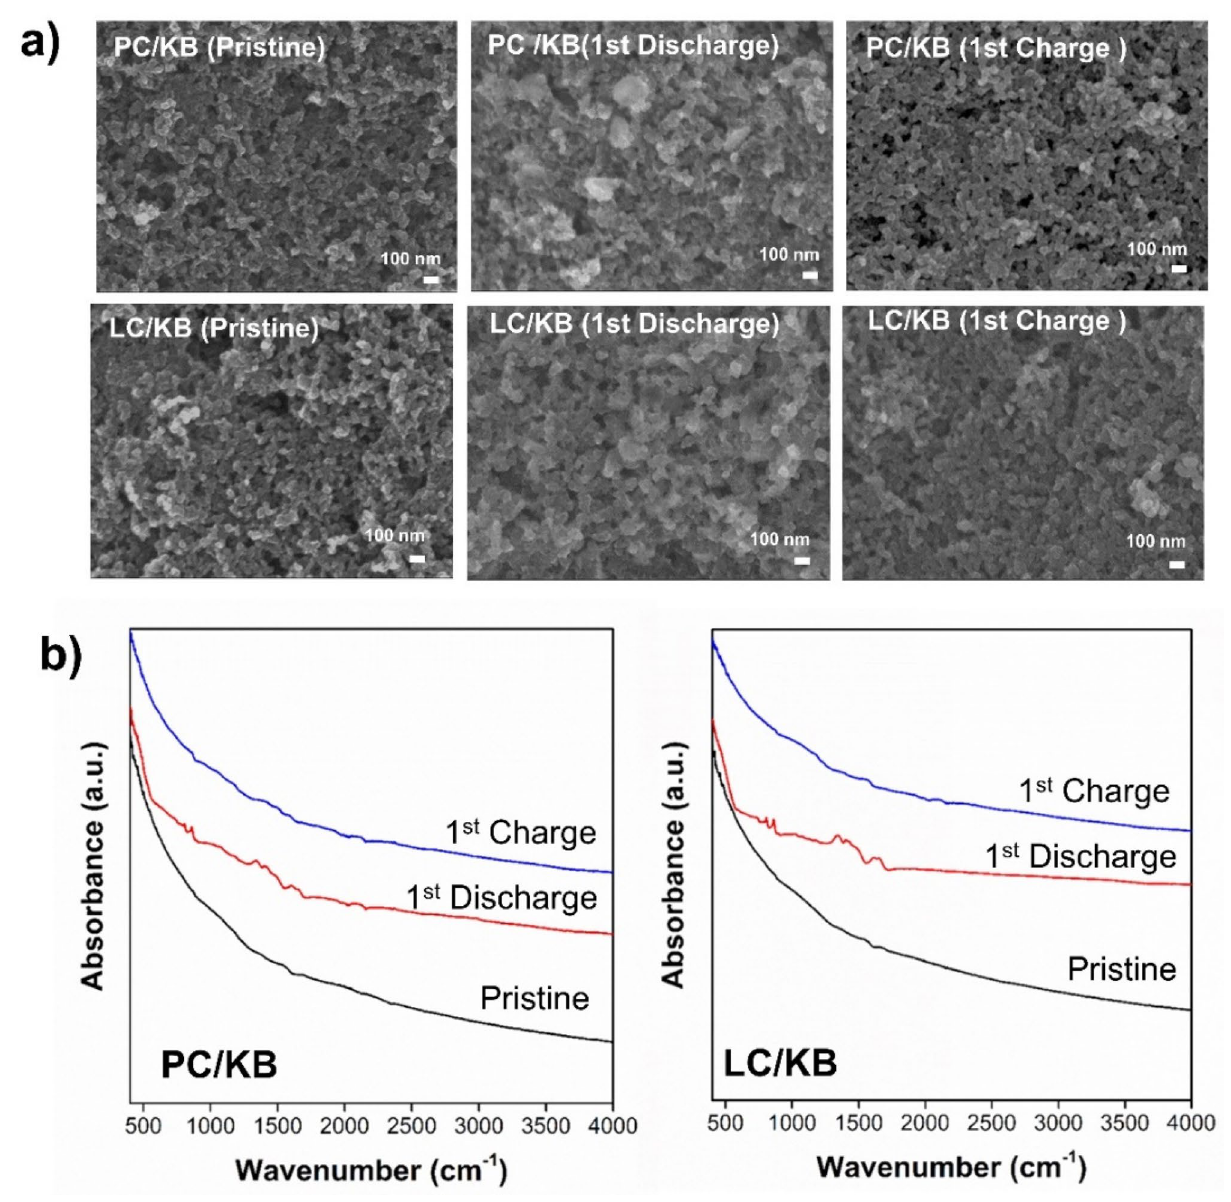
Figure 7. ( a ) FE-SEM images and ( b ) FT-IR spectra of PC/KB and LC/KB cathodes from the initial full discharged cells at current density of 200 mA g –1 and cut-off voltage of 2